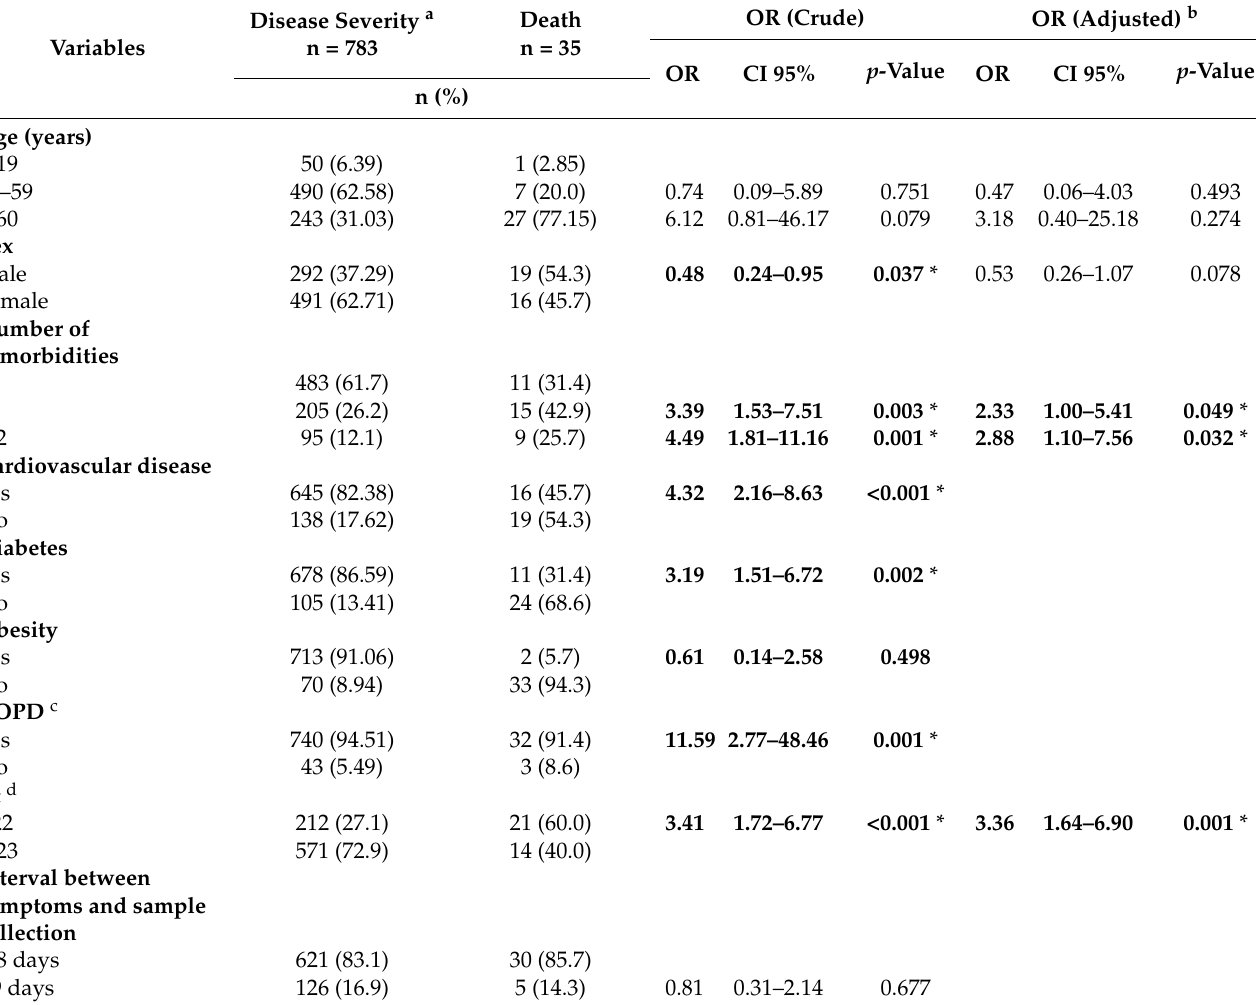
Table 3. Risk factors for death from COVID-19 in patients from Vit ó ria da Conquista, BA, Brazil.